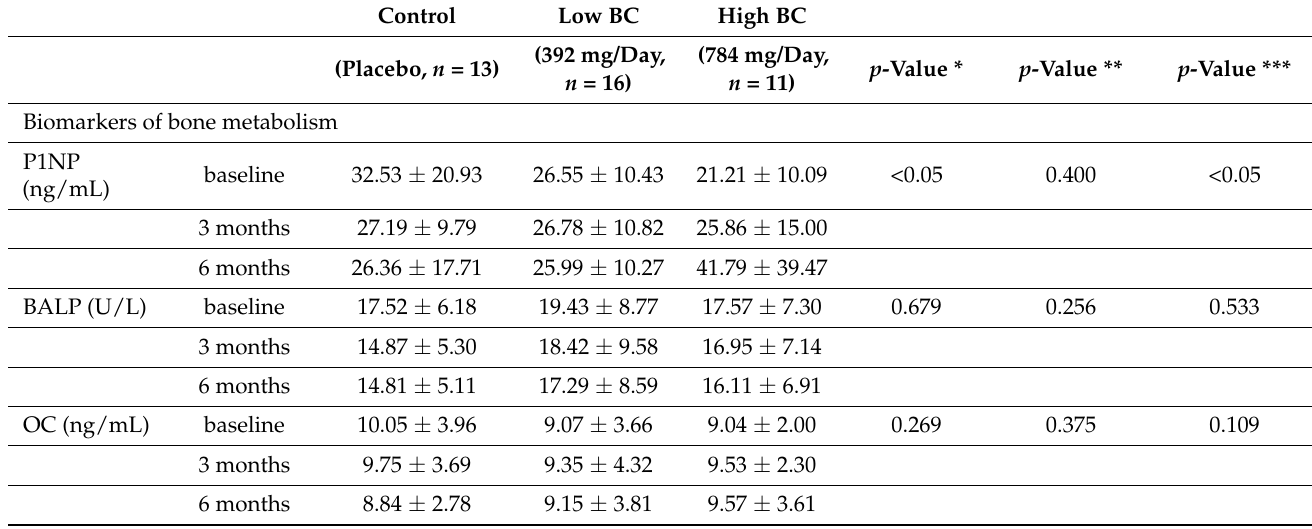
Figure 3. Changes (%) of amino-terminal propeptide of type 1 procollagen (P1NP), bone-specific alkaline phosphatase (BALP), osteocalcin (OC), carboxy-terminal crosslinked telopeptide of type 1 collagen (CTX-1), sclerostin, and BALP/CTX1 ratio from baseline after six months of consumption of placebo (control), 392 (low BC) and 784 mg (high BC) of blackcurrant powder. * Significance was assessed using one-way ANOVA. ** Significance was assessed using t-tests for comparing control and low BC and control and high BC groups, respectively. Table 5. Effect of different doses of blackcurrant powder on biomarkers of bone metabolism and immune-inflammatory status at baseline, three months, and six